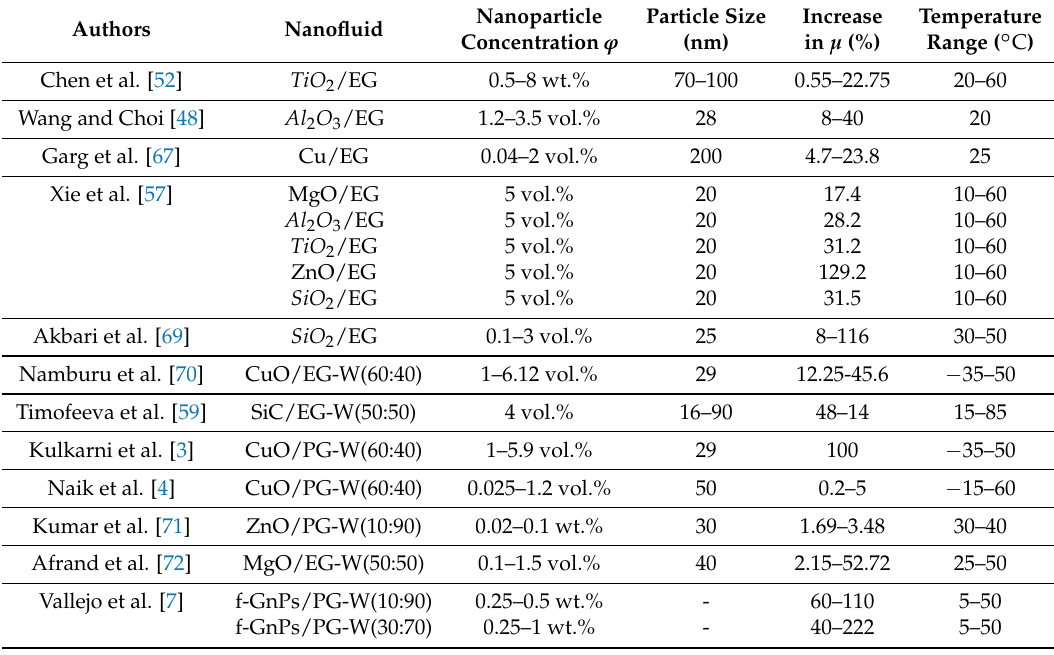
Table 5. Summary of the existing studies on the dynamic viscosity of EG- and PG-based nanofluids. f-GnPs, functionalized graphene